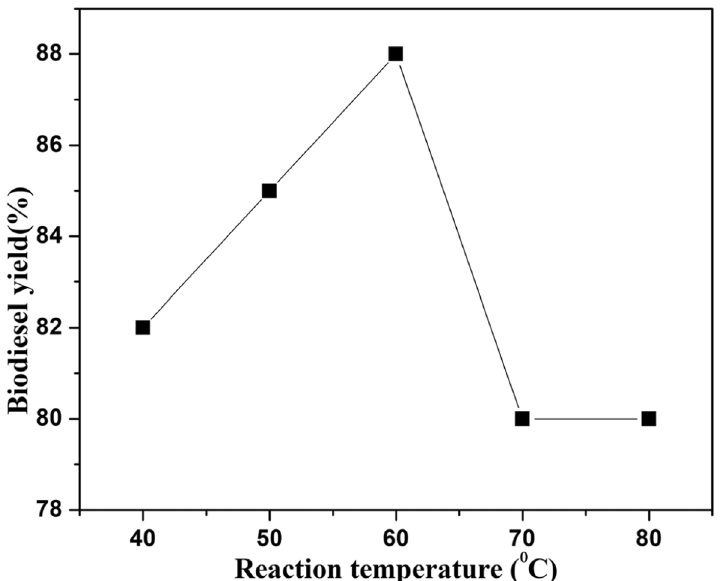
Fig. 9 Effect of reaction temperature (°C) on biodiesel yield in